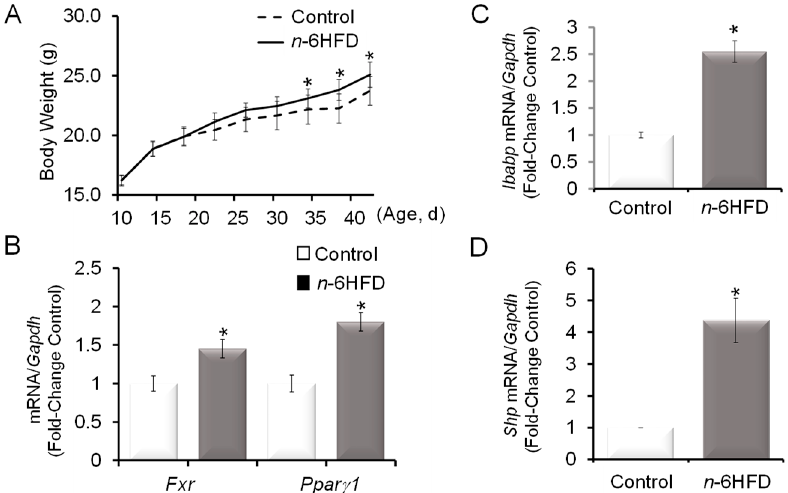
Figure 1. An n -6HFD (diet high in n -6 fatty acids) increases body weight and increases the expression of farnesoid-X-receptor ( Fxr ) in mouse colonic mucosa. ( A ) Weaned C57/BL6 male mice ( n = 6) were assigned to a control diet containing 13% energy (13%E, 5% by weight safflower oil (SO), 76% linoleic acid (LA)) or an n -6HFD containing 44 energy (44%E, 22% by weight SO) for 6 weeks. Bars represent means ± standard error of the mean (SEM) of quantitation (fold change of control) of ( B ) Fxr and peroxisome proliferator-activated receptor γ 1 ( Ppar γ 1 ), ( C ) ileal bile acid-binding protein ( Ibabp ), and ( D ) small heterodimer protein ( Shp ) mRNA corrected for glyceraldehyde dehydrogenase phosphate ( Gapdh ) mRNA as an internal standard. Means ± SEM (standard error of the mean) with an asterisk (*) differ ( p < 0.05).